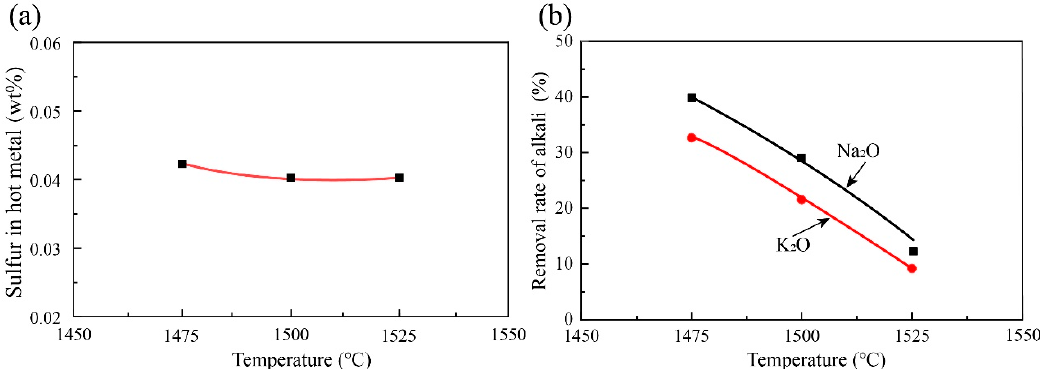
Figure 3. Effect of temperature on the desulfurization and the removal of alkali at slag-to-metal ratio of 200 kg/t ( a ) Desulfurization; ( b ) the removal of alkali.